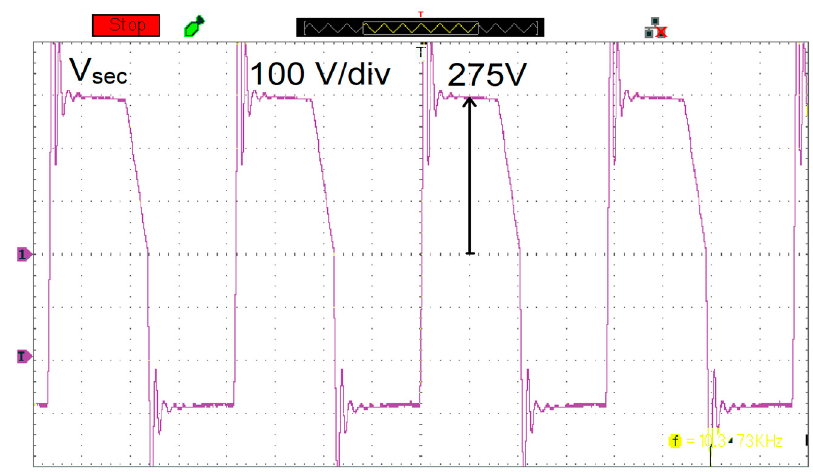
Figure 19. Secondary voltage of high-frequency transformer.